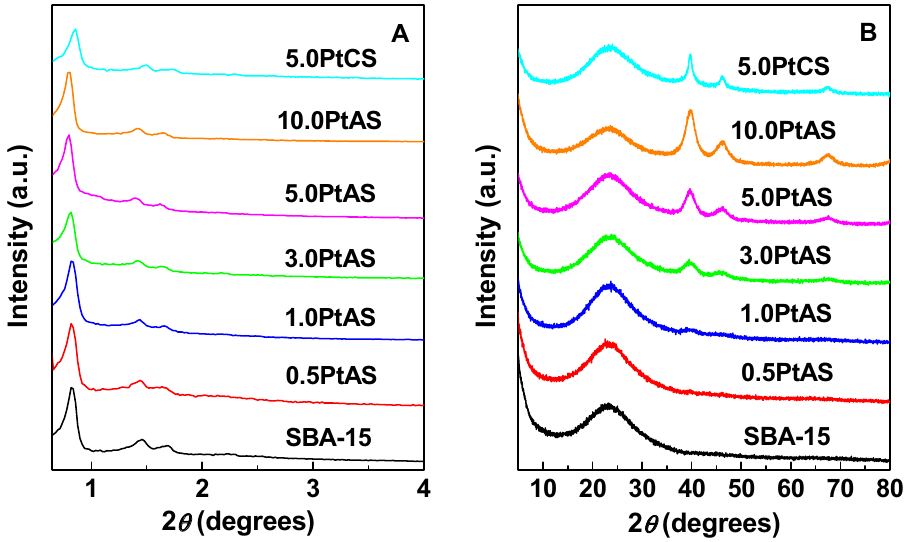
Figure 2. ( A ) Low-angle and ( B ) wide-angle XRD patterns for the samples of SBA-15, PtAS and PtCS.